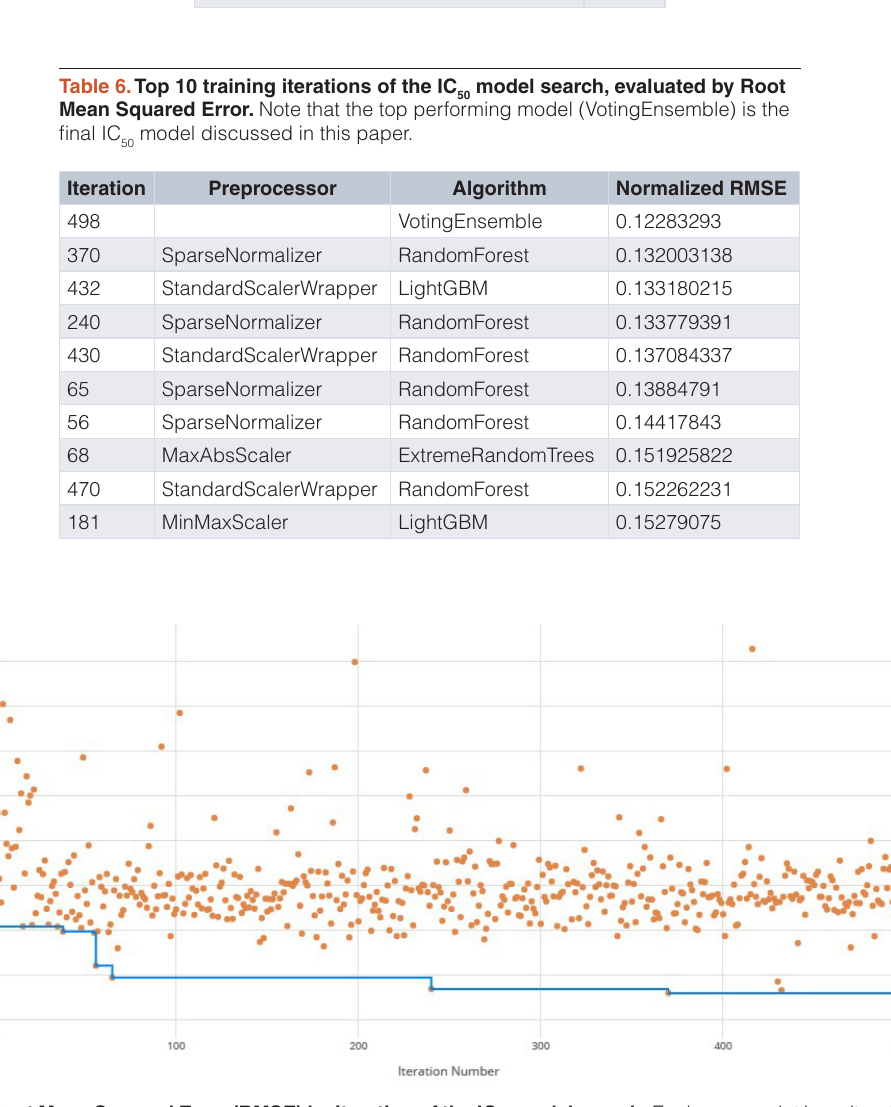
Table 5. Model metrics of the final IC